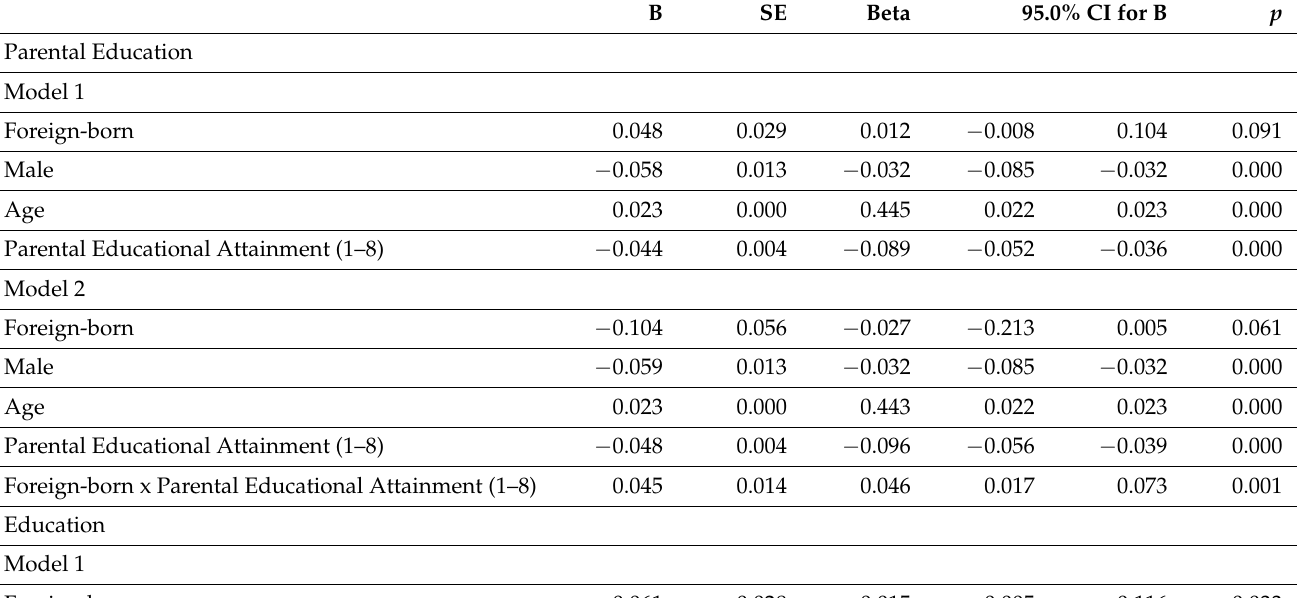
Table 2. Summary of linear regressions in the pooled